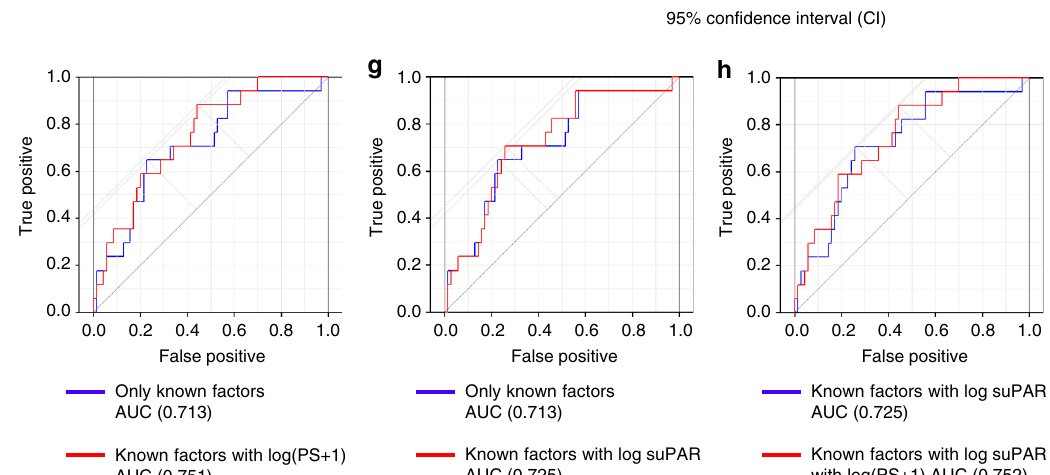
DKD patients, especially with microalbuminuria.